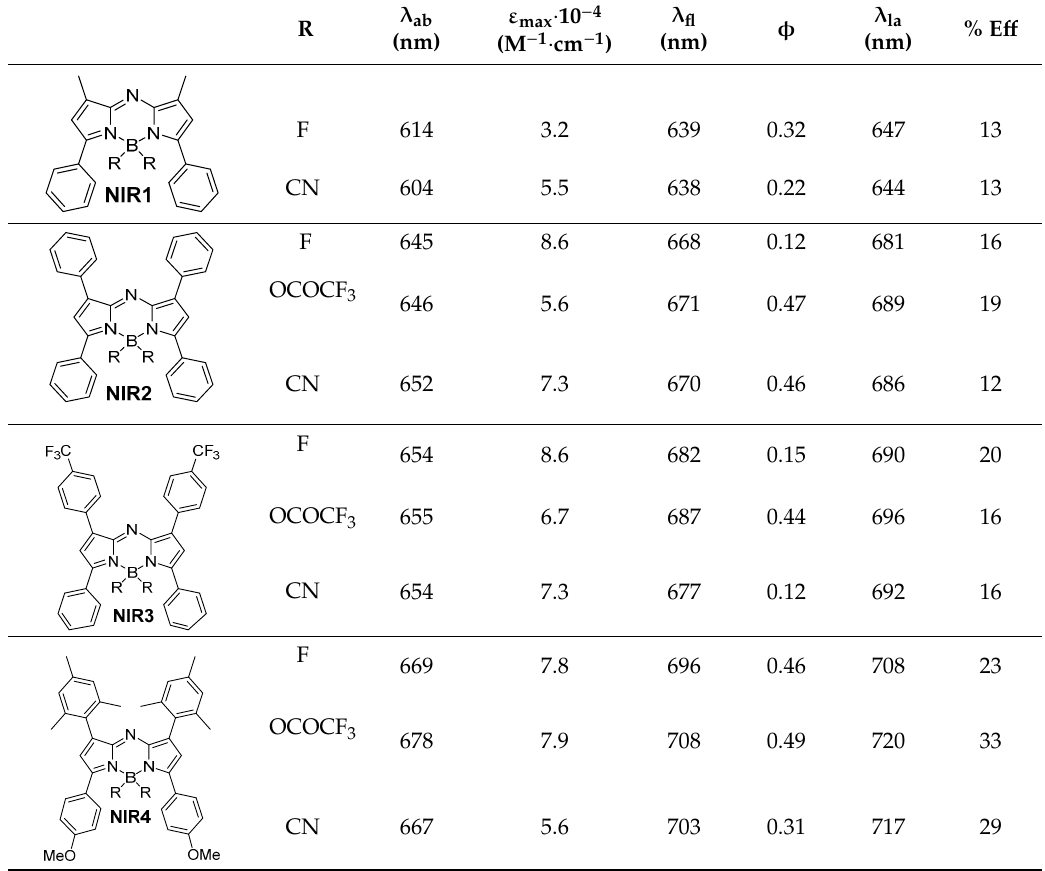
Table 1. Molecular structure of the NIR aza-BODIPYs and their corresponding main photophysical (at diluted solutions of 2 µ M) and laser (at the optimal dye concentration ranging from 0.25 mM to 1 mM) data in ethyl acetate: absorption wavelength ( λ ab ), molar absorption coefficient ( ε max ), fluorescence wavelength ( λ fl ), quantum yield ( φ ), laser wavelength ( λ la ), and efficiency (% Eff). The corresponding O -aza-BODIPY in NIR1 could not be isolated owing to its chemical instability.